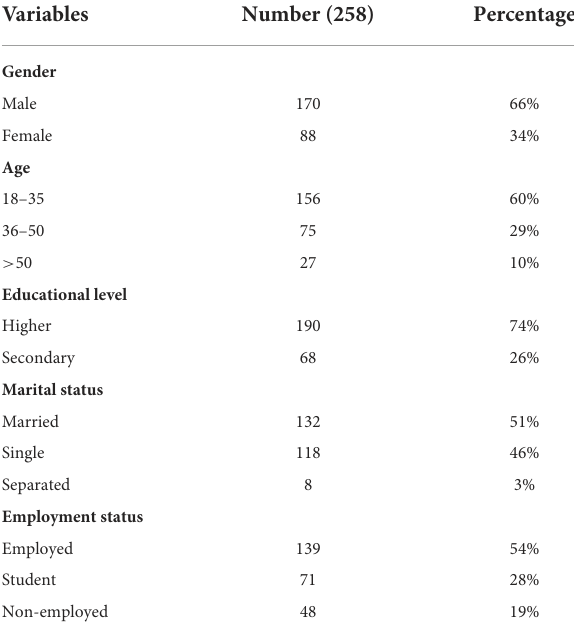
TABLE 1 Sociodemographic properties of the